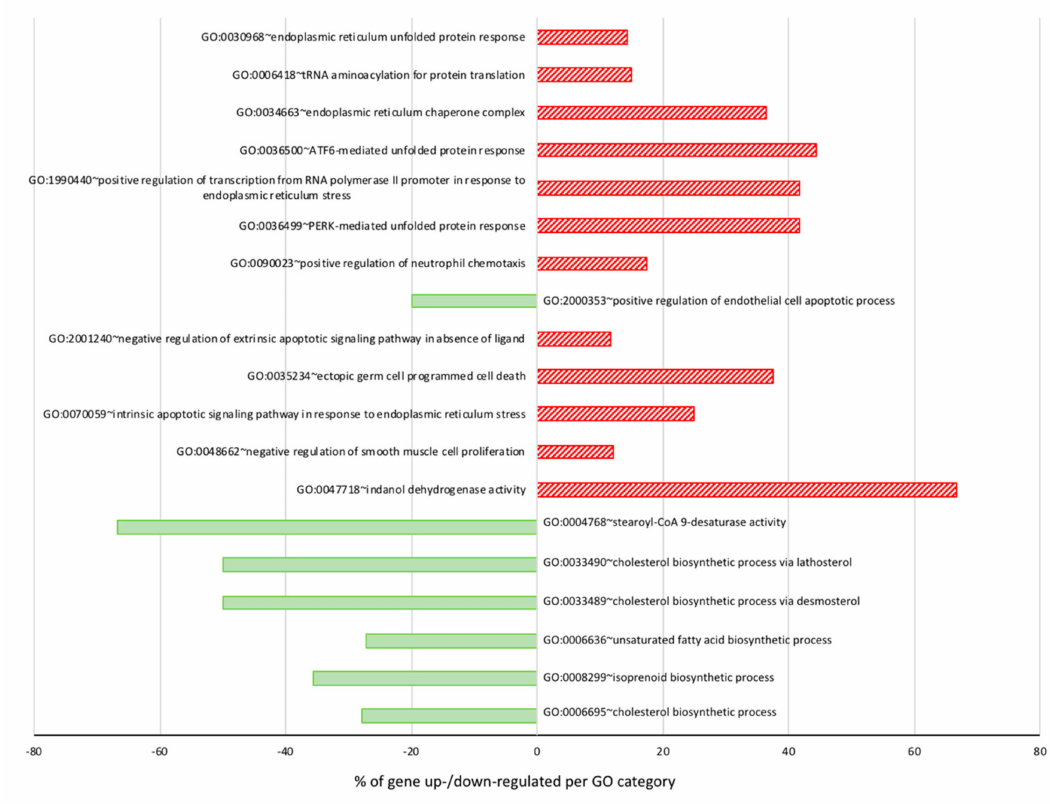
Figure 3. Percentage of genes per Gene Ontology category up- or downregulated following 24 h DHA treatment. Data were extracted from Table S4. Green bars on the left represent downregulated genes, whereas red hatched bars on the right are for upregulated group of